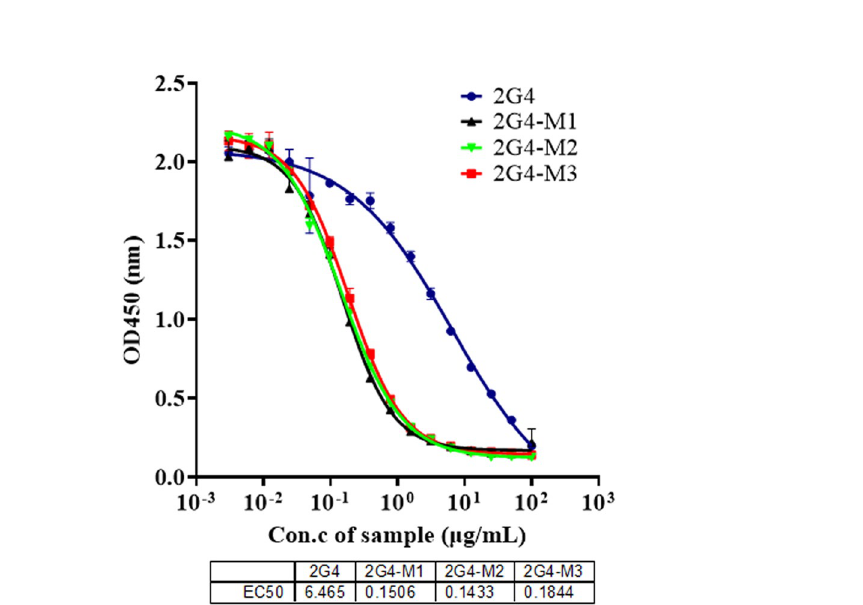
Figure 6. Confirmation of N protein epitope drift by competitive ELISA. A representative experiment out of two independent experiments is